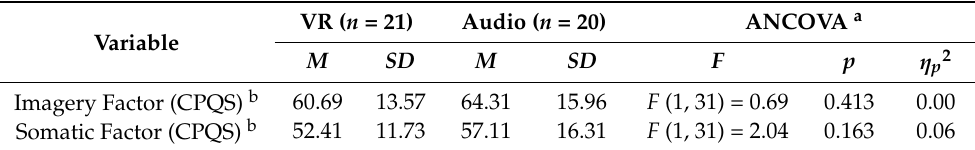
Table 4. Means and standard deviations of scores on compassion practice